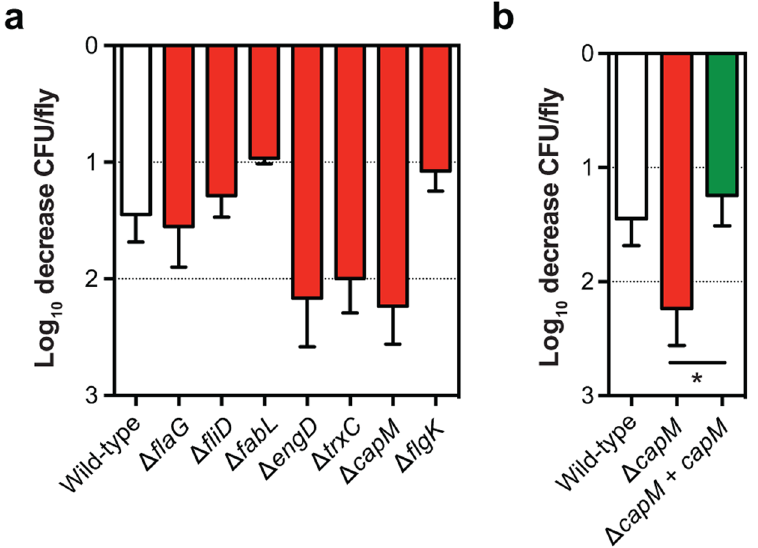
Figure 4. Validation of Tn mutant library screen during survival in the housefly. ( a ) Survival (Log 10 decrease inoculum vs recovered) of defined C . jejuni M1 gene deletion mutant in the housefly after 4 h. ( b ) Survival of wild-type, capM defined gene deletion mutant and genetically complemented mutant. Data shown are Log 10 decrease of CFU per fly relative to the inoculum and plotted as means with SEM ( n ≥ 4). Significance was analysed using a Mann-Whitney test with * P <